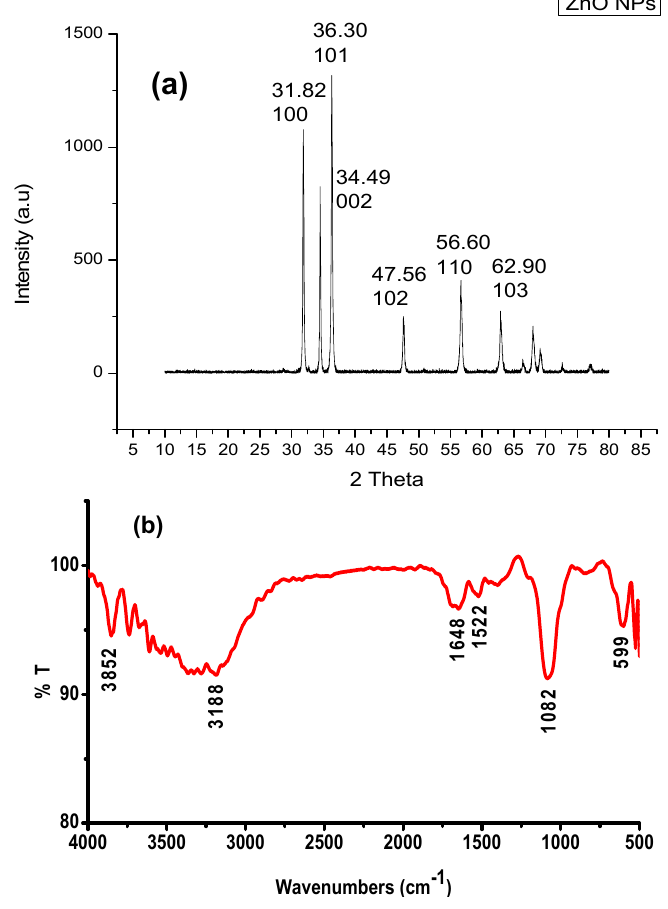
Figure 2. ( a ) X-ray diffraction (XRD) patterns of biosynthesis of ZnO NPs using aqueous extract of E. prostrate ; ( b ) Fourier transform infrared spectroscopy (FTIR) peaks of synthesized ZnO NPs using E . prostrata aqueous leaf